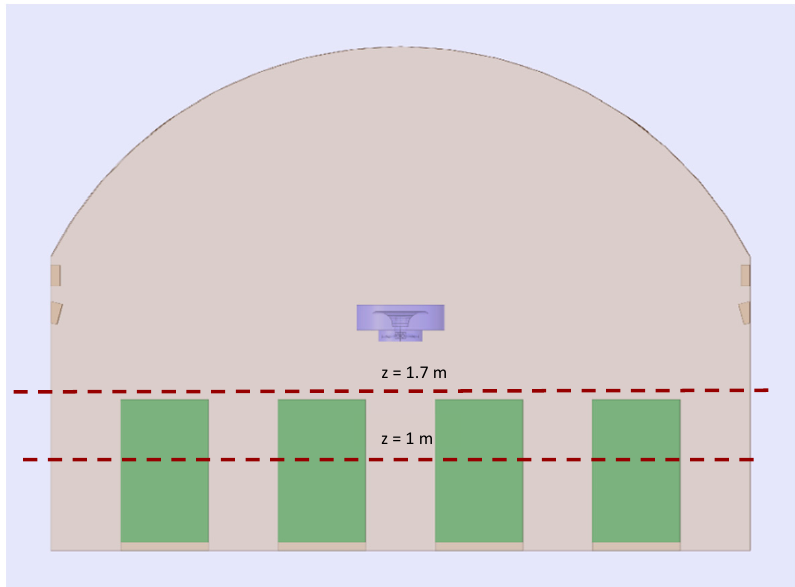
Figure 6. 2D sectional view showing the plane heights.